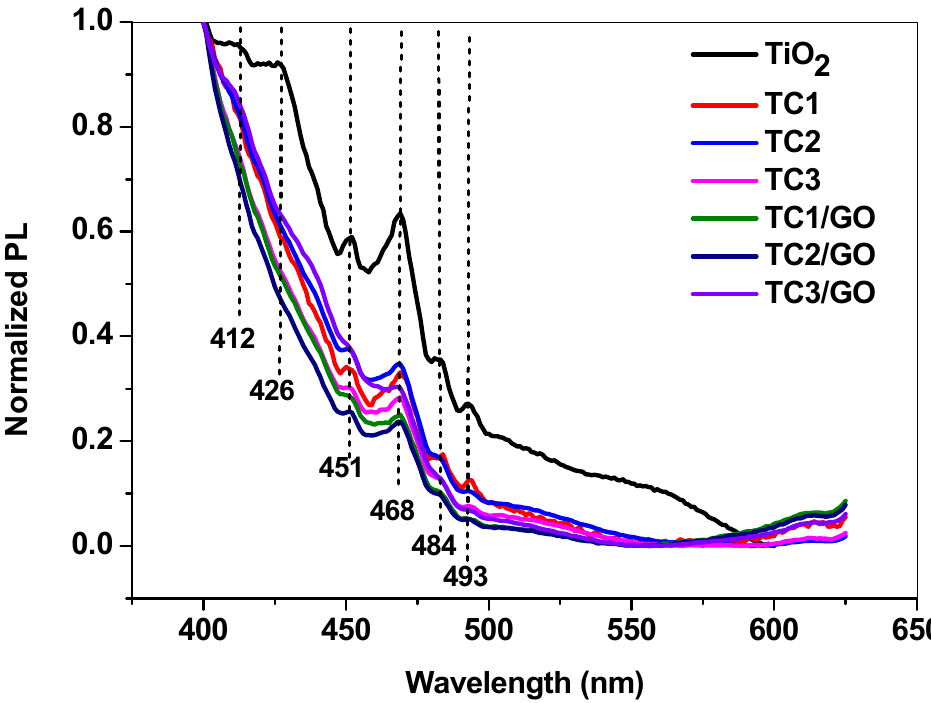
2 nanoparticles.